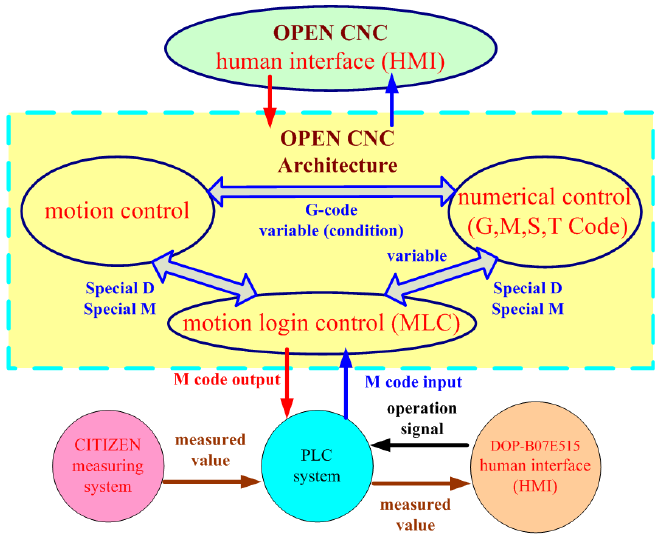
Figure 6. Flow diagram of the measurement based on OPEN CNC.